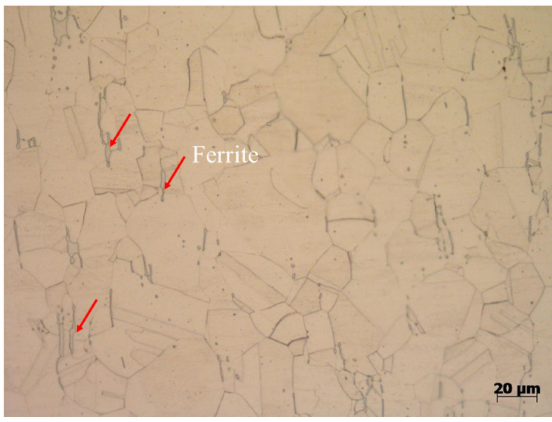
Figure 1. Optical microstructure of SS 321 sheet.